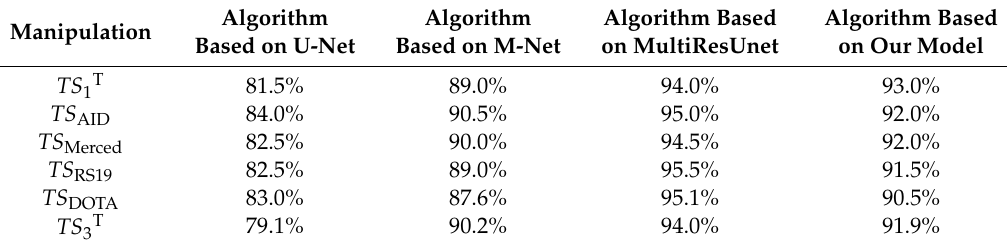
Table 5. Comparison of robustness test of adding noise ( T h is set to 0.02).